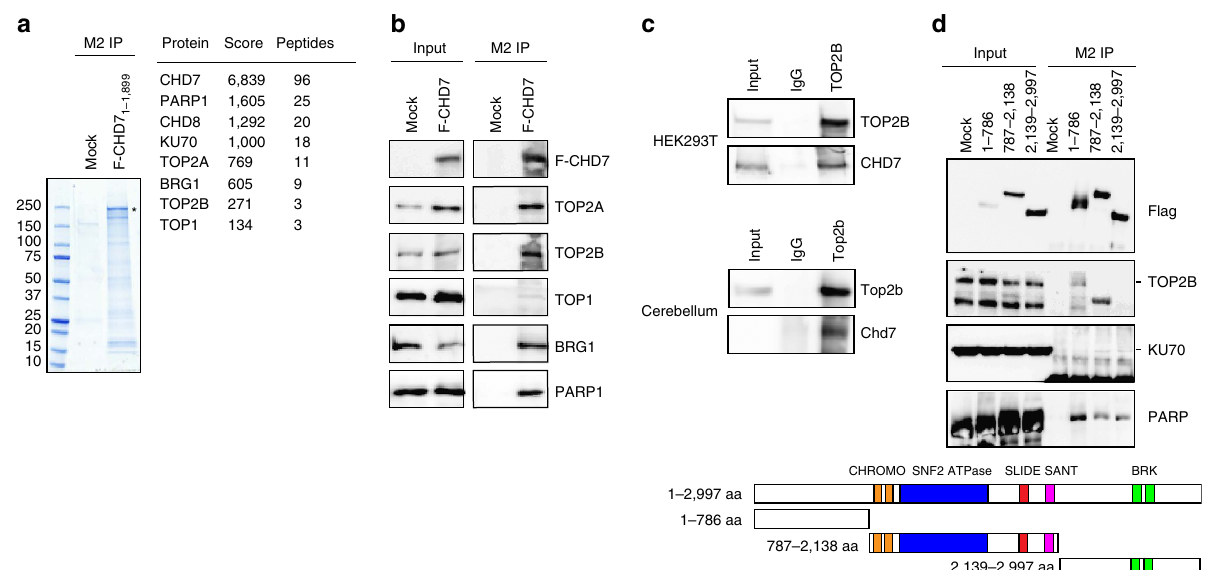
Figure 5 | Chd7 interacts with Top2b. ( a ) Coomassie-blue staining of an SDS gel shows immunoprecipitation using M2 beads in CHD7 KO HEK293Tcells overexpressing a Flag-tagged truncated CHD7 1 – 1,899 (highlighted with asterisk). Cells transfected with an empty vector served as mock control. Numbers on the left side indicate the molecular weight. A list of proteins identified by mass spectrometry, peptides of which were exclusively present in CHD7- immunoprecipitation but not mock control, is shown in the right panel. Scores and numbers of unique peptides identified for each protein are shown. ( b ) Immunoblotting of CHD7-interacting proteins precipitated with M2 beads in nuclear extracts from HEK293T cells overexpressing a Flag-tagged full-length CHD7 (F-CHD7) or mock-transfected cells. Forty per cent of IP and 2.5% of the input are shown. ( c ) Co-immunoprecipitation assay shows the interaction between endogenous Chd7 and Top2b in HEK293T and adult (6-week-old) mouse cerebella. Cell lysates were immunoprecipitated with an antibody against Top2b, and co-precipitated Chd7 was visualized by western blots. Five per cent of input and 100% of IP are shown. Note that endogenous Chd7 in adult cerebella was only detected by western blot after enrichment by immunoprecipitation. ( d ) The N-terminal part of CHD7 interacts with TOP2B. Cell lysates from HEK293T cells transfected with a series of constructs encoding Flag-tagged truncated CHD7 proteins were precipitated with M2 beads, and precipitated proteins were visualized by western blots. Fifty per cent of IP and 4% of the input are shown. Bands corresponding to TOP2B and KU70 according to their molecular weight are pointed with lines. The schemes illustrate the domain structure of full-length and truncated CHD7 protein used in the